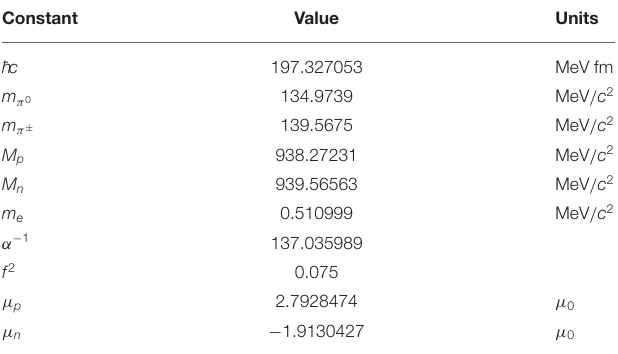
TABLE 1 | Values of fundamental constants